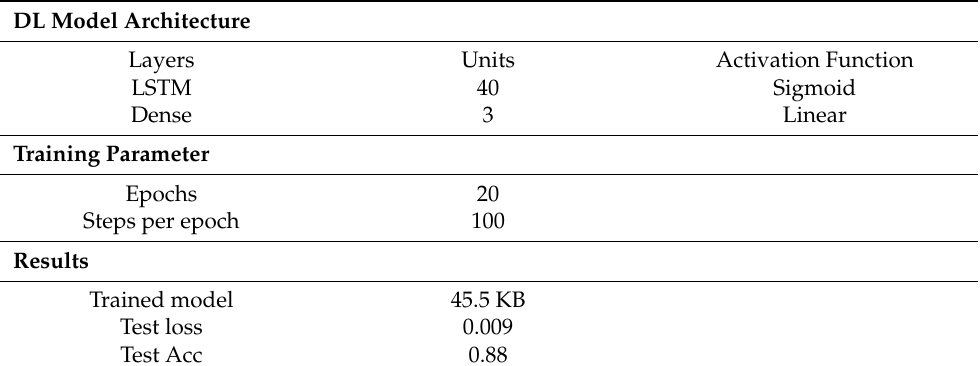
Table 3. Deep Learning model architecture, parameters, and training and test results.